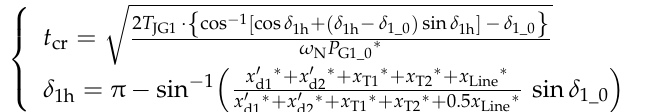
For the convenience of calculation, several assumptions are made: